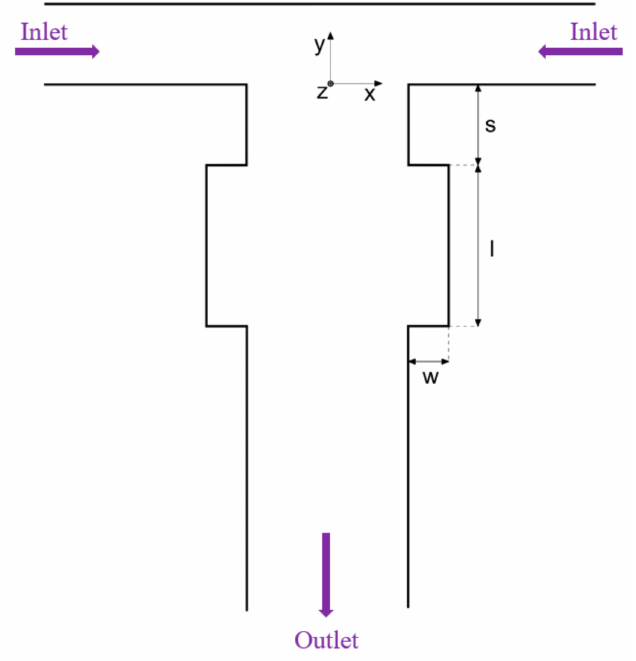
Figure 3. Sketch of the geometry proposed by Antognoli et al. Adapted from an open-access source